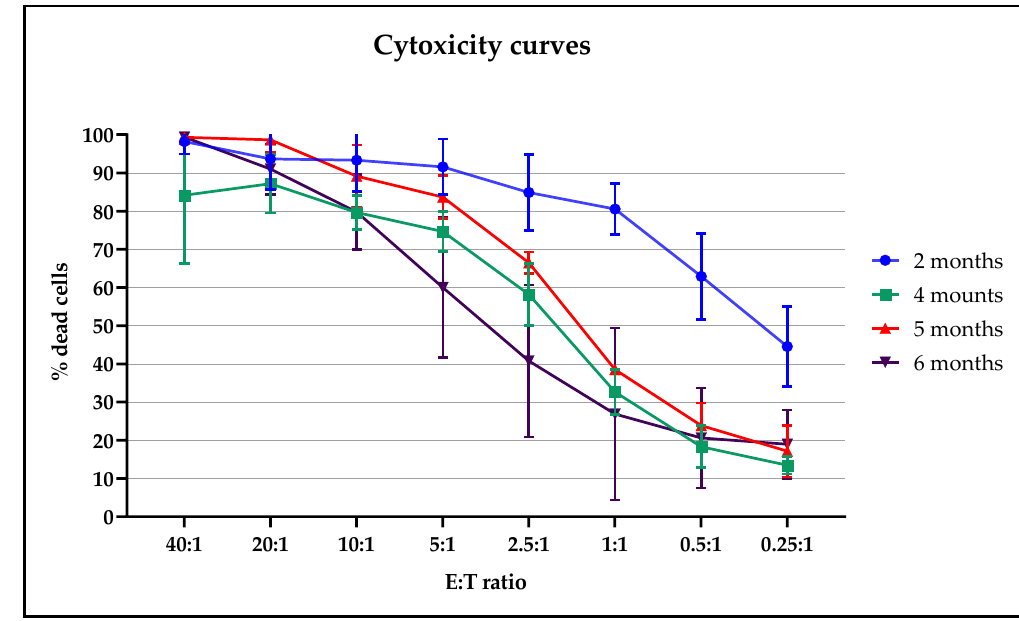
Figure 6. Cytotoxicity curves evaluated at various post-thawing time periods with scalar effector and target (E:T) ratios.